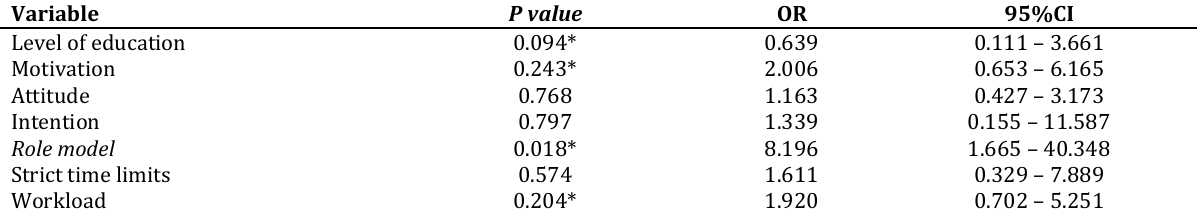
Table 4. The recapitulation of the relationship between the level of education, motivation, attitude, intention, role model, strict time constraints and workloads with the implementation of the handover in the inpatient ward of Ulin Hospital